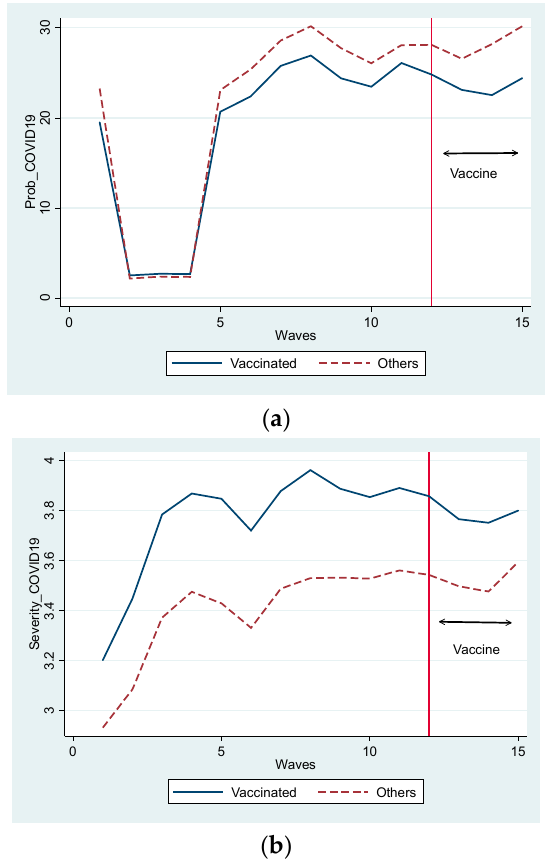
Figure 1. ( a ) Change of Probability of COVID-19. ( b ) Change of Severity of COVID-19. Nobody was vaccinated before the 12th survey (28–31 May 2021), as shown in the left part of the vertical line in Figure 1. Figure 1 suggests how people who were not vaccinated behaved di ff erently from vaccinated people in the period when the vaccine was not dis-